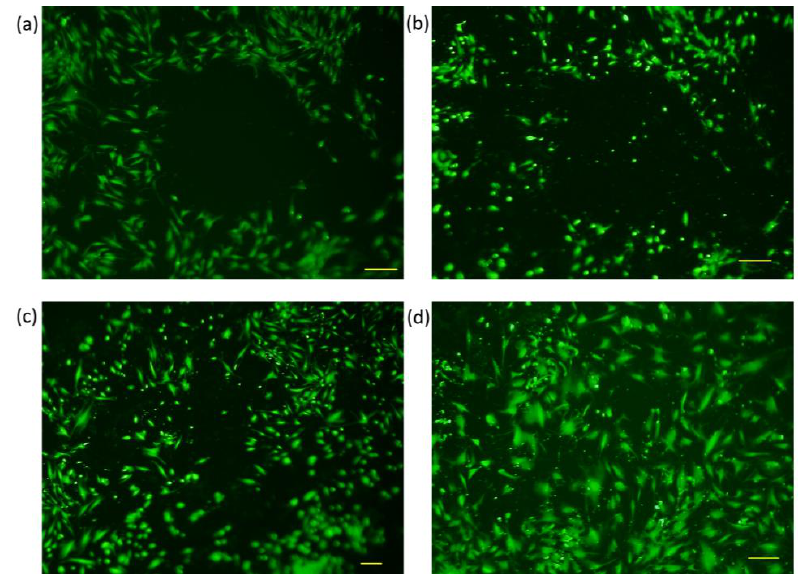
Figure 6. Fluorescence microscopy images of dermal fibroblasts from a 28-year-old donor at four different time frames (Training Group) ( a ) Initial, ( b ) 24 h, ( c ) 48 h, and ( d ) 4 days .